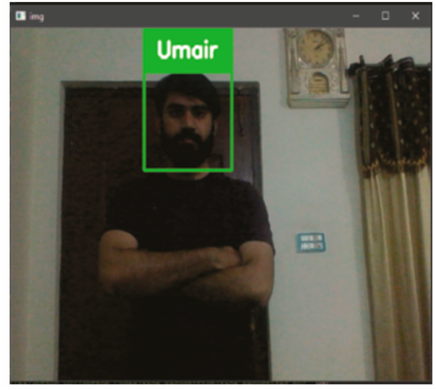
Figure 19. Facial